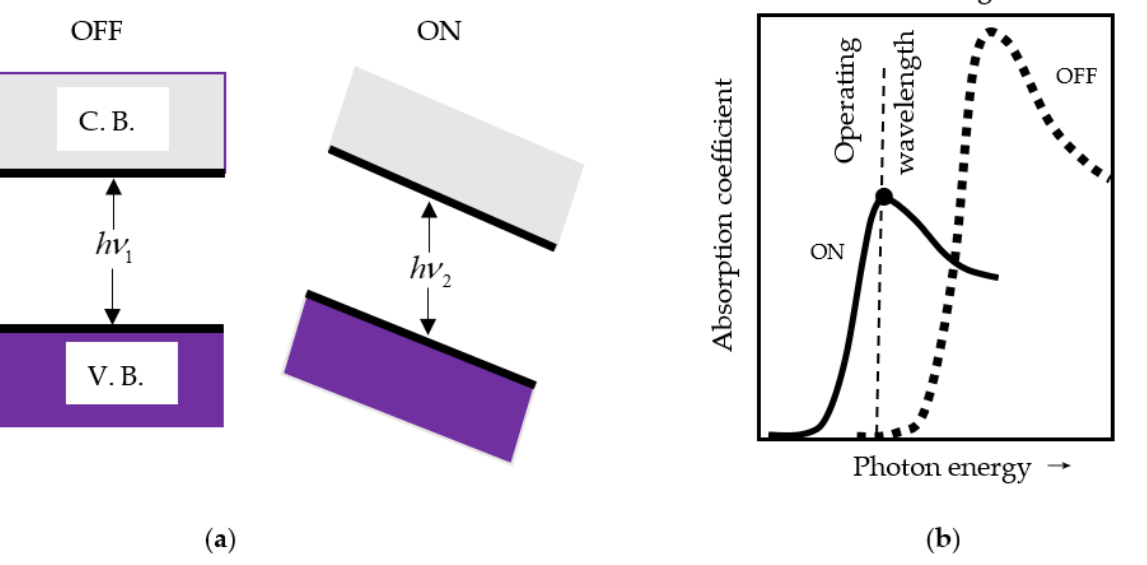
Figure 1. The Franz – Keldysh effect. ( a ) The bandgap in the absence of an external electric field (OFF) is reduced in its presence (ON). ( b ) Change in the absorption spectrum caused by the presence of an electric field. The absorption peak moves toward longer wavelengths. C. B. and V. B are conduction band and valence band, respectively.